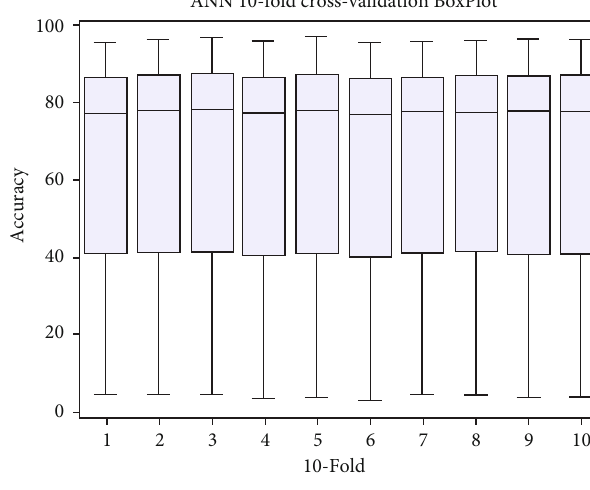
9: Box plot representation for